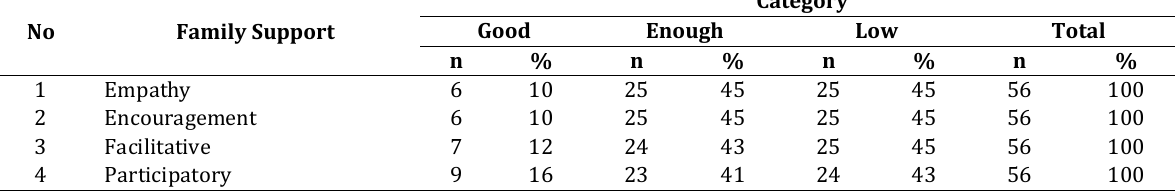
Table. 2 Family Support to Leprosy Patients in Probolinggo District.